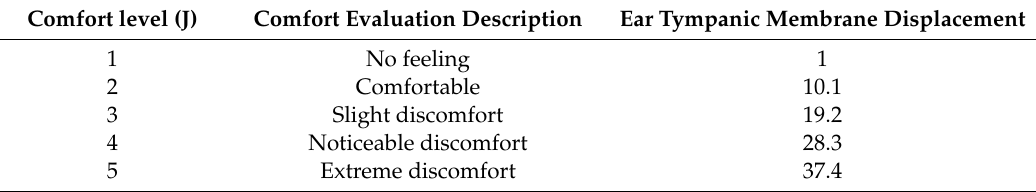
Figure 4. Relationship between air pressure change and eardrum displacement ( a ); relationship between air pressure change rate and eardrum displacement ( b ); relationship between air pressure change value and eardrum displacement. Table 1. Comfort evaluation standard for ear tympanic membrane displacement.